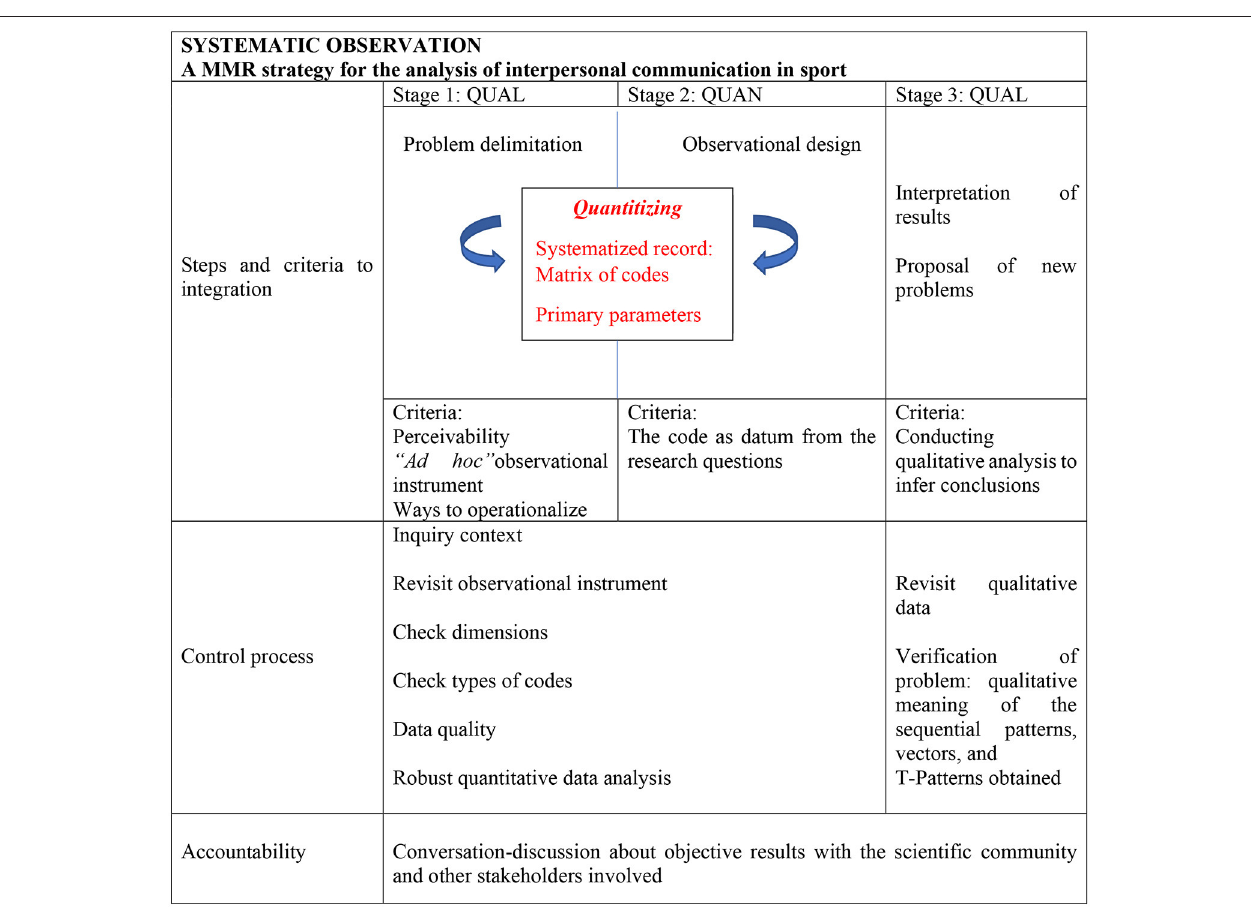
FIGURE 4 | Integrating data, Quantitizing , and analysis in systematic observation: Steps (row 1), Control process (row 2), and Accountability (row